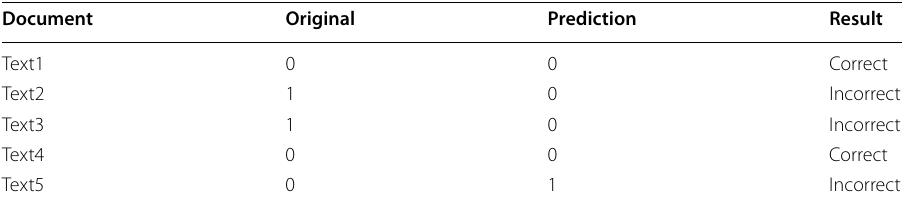
Table 17 Testing set prediction document example